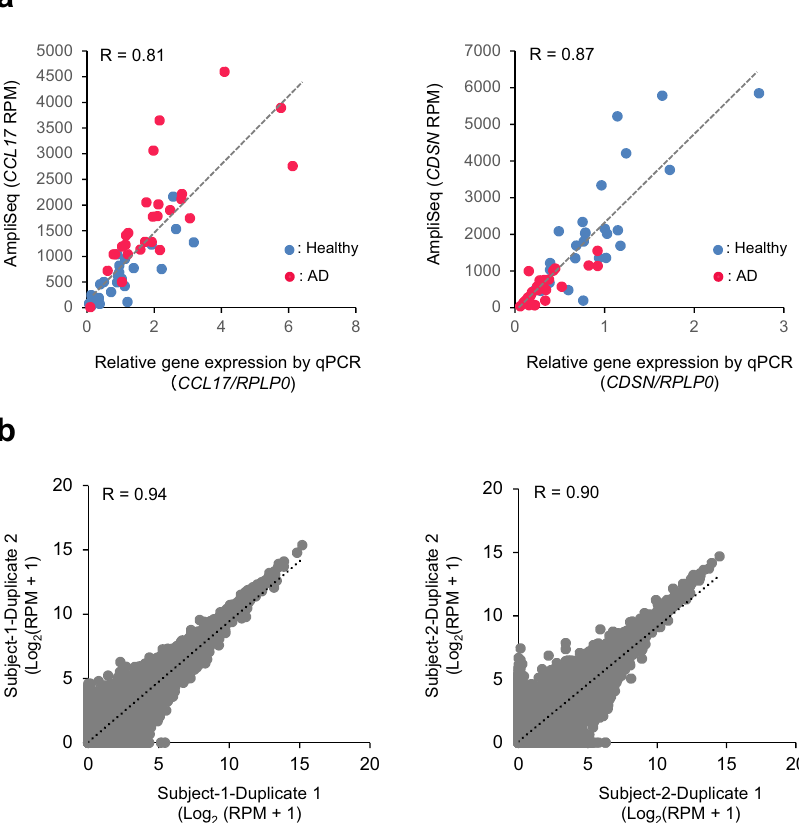
Fig. 3 Accuracy of the AmpliSeq data output using the modi fi ed protocol. a The correlation between AmpliSeq and qPCR results for CCL17 and CDSN expression in healthy subjects ( n = 29, blue) and patients with AD ( n = 30, red). b The correlation of the transcriptome pro fi le when preparing libraries in duplicate from each SSL-RNA obtained from two healthy male